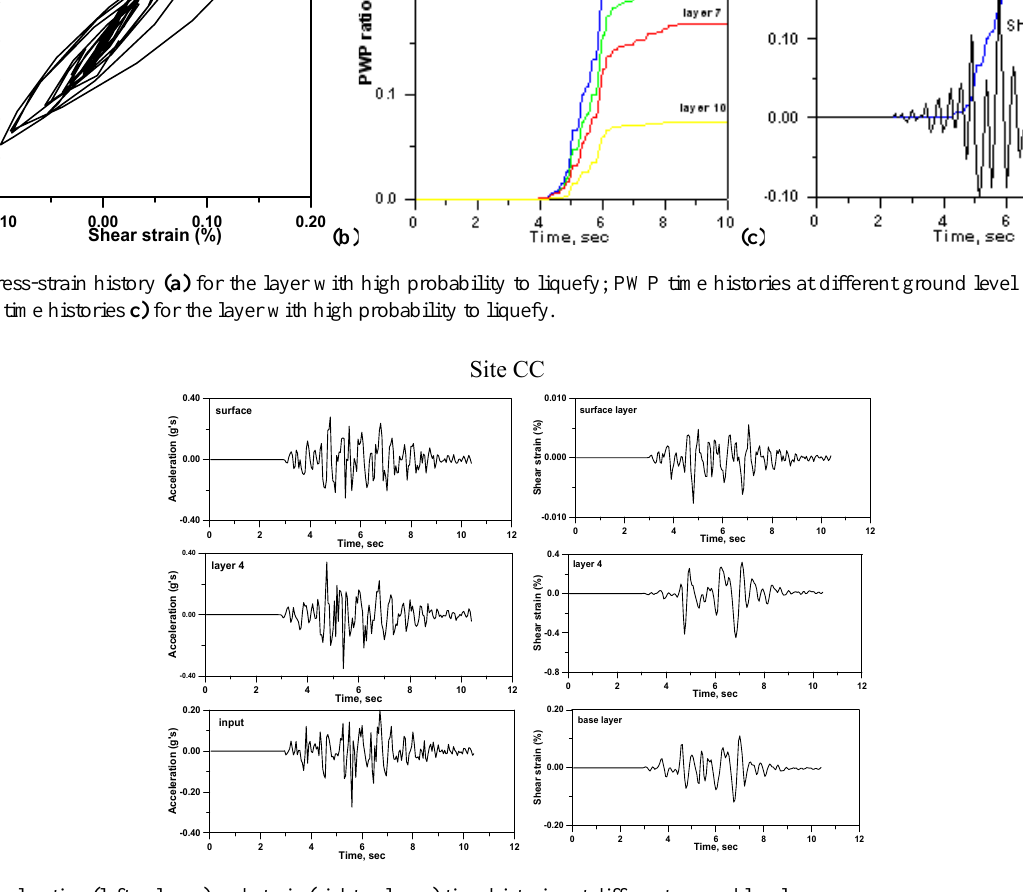
Fig. 15. Acceleration (left column) and strain (right column) time histories at different ground Figure 15 .